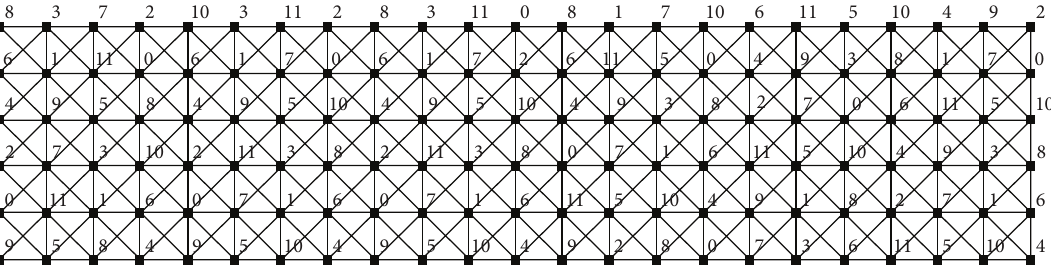
Figure 10: 11 - 𝐿(2, 1) -labeling of 𝑃 6 ⊠ 𝐶 23